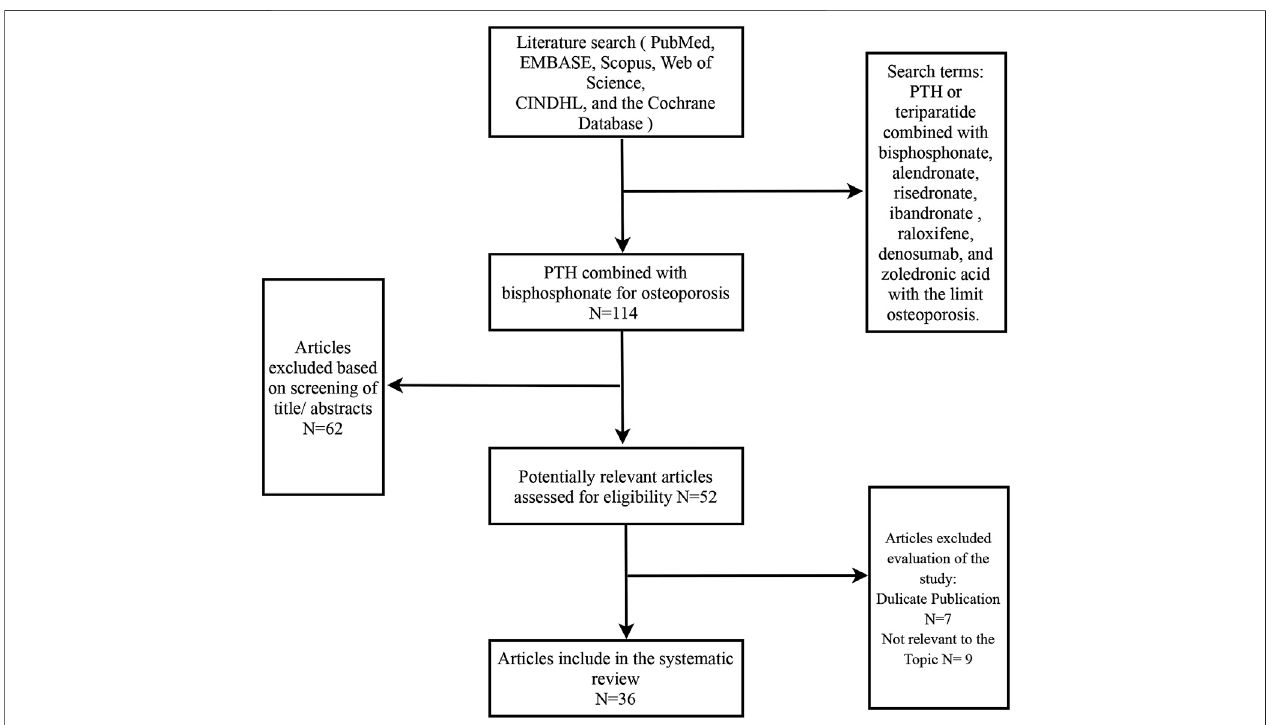
FIGURE 2 | Flow diagram of study selection process. Initially 114 studies were identi fi ed. The review process resulted in 36 studies included in this systematic review.